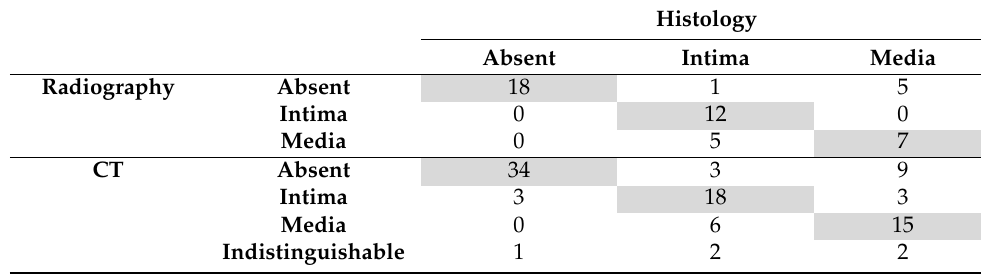
Table 1. Inter-method agreement for both radiograph and CT for the experienced